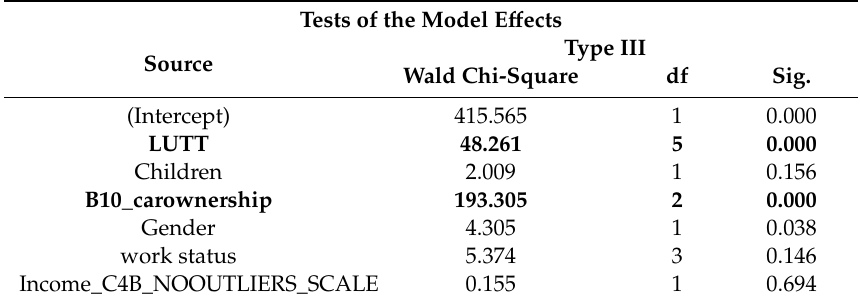
Table A6. Test of the Model E ff ects, with Statistically Significant Factors in Bold